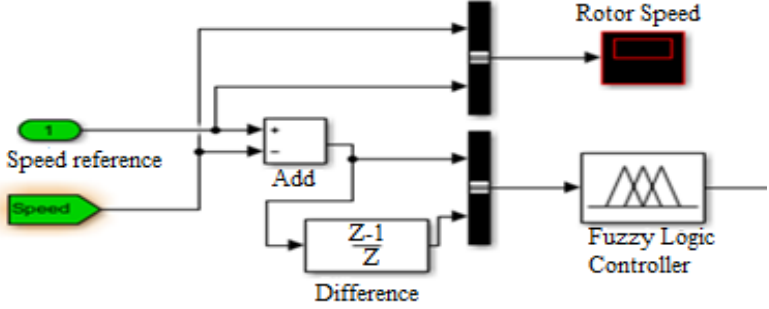
Figure 24. Simulink-based model of the speed controller using fuzzy logic.